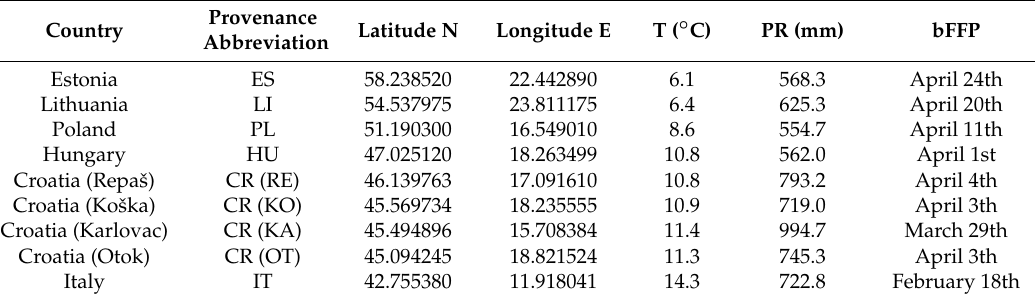
Table 1. Location and climatic characterization of the provenance